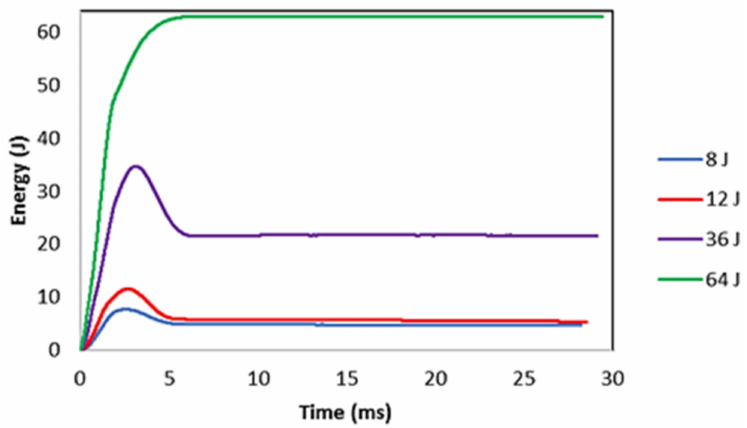
Figure 7. Comparisons of energy-time plot generated from the drop-weight impact for the investi- gated laminates at different energy